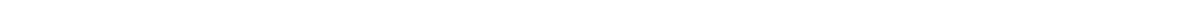
Figure 1 | L-type calcium channel blockers (CCBs) inhibit filopodia formation and L-type calcium channels are functional in cancer cells. ( a ) MDA-MB- 231 cells transiently expressing MYO10-GFP and adhering to fibronectin (FN) were treated with various compounds (10 m M) for 1h, fixed, stained for actin and imaged on a TIRF microscope (scale bar, 20 m m). The number of MYO10-positive filopodia was counted for each cell and displayed as a box plot (three biological repeats, n 4 100 cells, *** P value o 8.3 (cid:3) 10 (cid:2) 17 ). ( b ) Relative expression of the four genes encoding the L-type calcium channel a 1 subunit across 676 commonly used cancer cell lines 19 . Gene expression read counts are displayed. The value 7.99 corresponds to non-detected (ND). Selected cell lines are annotated. ( c ) MDA-MB-231 cells transiently expressing the calcium probe (pGP-CMV-GCaMP6s) and adhering to FN were treated with an L-type calcium channel activator (BAY K8644; 1 m M) while being imaged on a TIRF microscope (63 (cid:3) objective). The relative increase in the intracellular intensity of the calcium probe was measured at 1 and 10min post stimulation. Cell boundaries are indicated by dotted lines (three biological repeats, n ¼ 74 cells; scale bar, 20 m m). ( d ) MDA-MB-231 cells transiently expressing the calcium probe (pGP-CMV-GCaMP6s) and MYO10-mCherry were seeded on FN and treated with an L-type calcium channel activator (BAY K8644; 1 m M) while being imaged on a TIRF microscope (100 (cid:3) objective; scale bar, 10 m m). The inset shows a representative MYO10-positive filopodia tip delineated by a dotted line. ROI: region of interest. ( e ) MDA-MB-231 cells transiently expressing the calcium probe (pGP-CMV-GCaMP6s) and adhering to FN were treated with an L-type calcium channel activator (BAY K8644; 1 m M) in combination with DMSO or amlodipine besylate (1 m M). The relative increase in the intracellular intensity of the calcium probe was measured at 1min (three biological repeats, n 4 21 cells; *** P value o 1.39 (cid:3) 10 (cid:2) 4 ). P values were calculated using Student’s t -test (unpaired, two-tailed, unequal